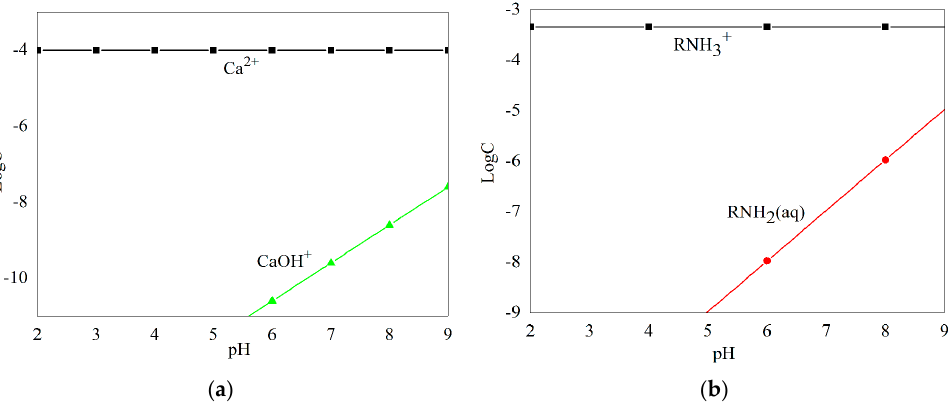
Figure 7. Species distribution diagrams of 1.00 × 10 − 4 M Ca 2+ ions ( a ) and 4.50 × 10 − 4 M DAC ( b ) as a function of pH.